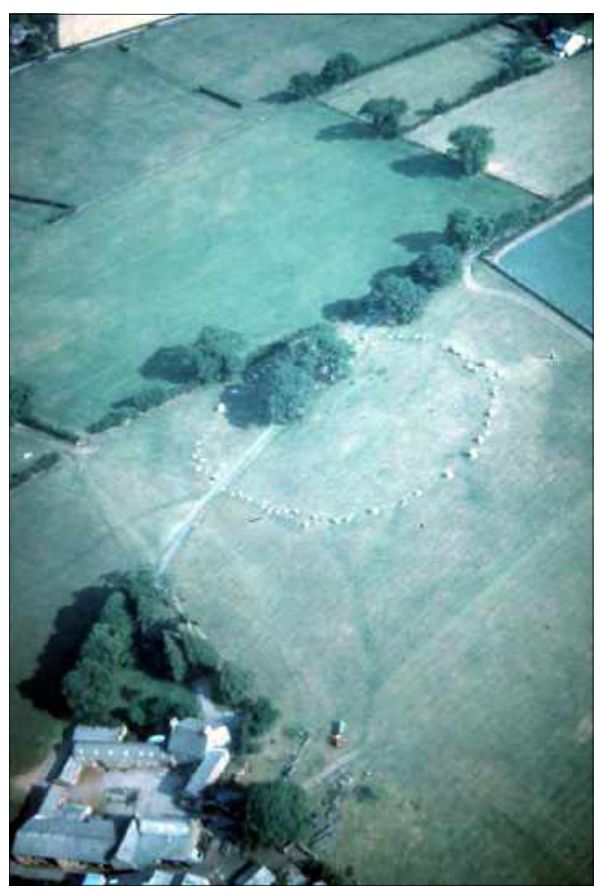
Fig 2.15 Aerial view of the Long Meg stone circle, Cumbria, revealing the cropmark of an adjoining enclosure (Cumbria County